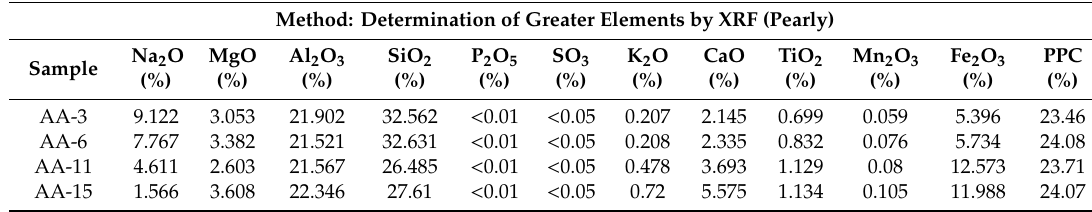
Table 14. XRF results of activated allophane.